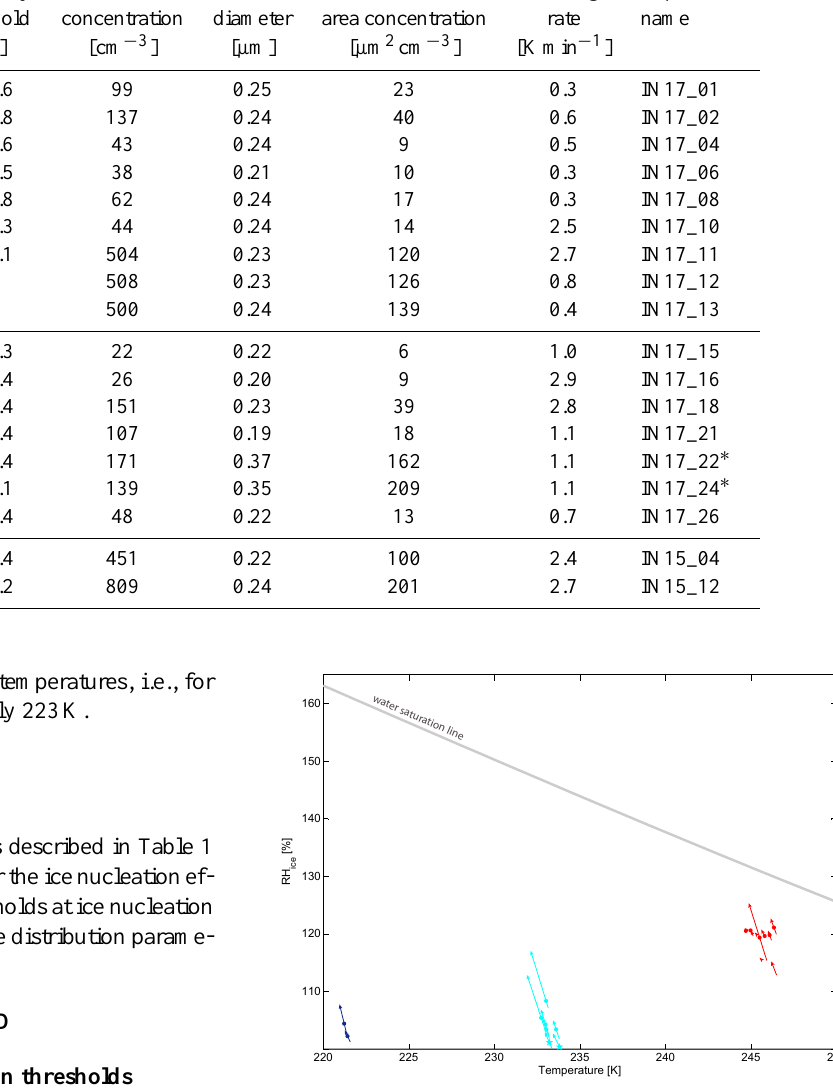
periments starting below 235 K are more similar to each other than those of the experiments at warmer